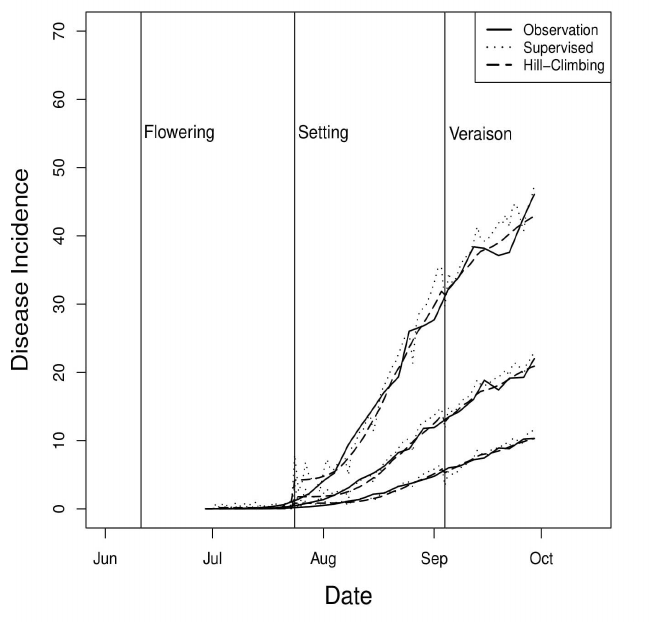
Figure 9. Model predictions of DI of PM for the three grape cultivars: High susceptible Chancellor (top), Medium susceptible Geisenheim-318 (middle), and the low susceptible Frontenac (bottom) in 2011. Model predictions from both supervised (dotted line) and algorithm (dashed line) learned Bayesian network are shown alongside the observed daily DI. The three vertical lines from left to right are the estimated plant stage of grapevine: flowering, setting, and veraison stages. DI of grape PM in 2011 started from 29 June until the end of the growing